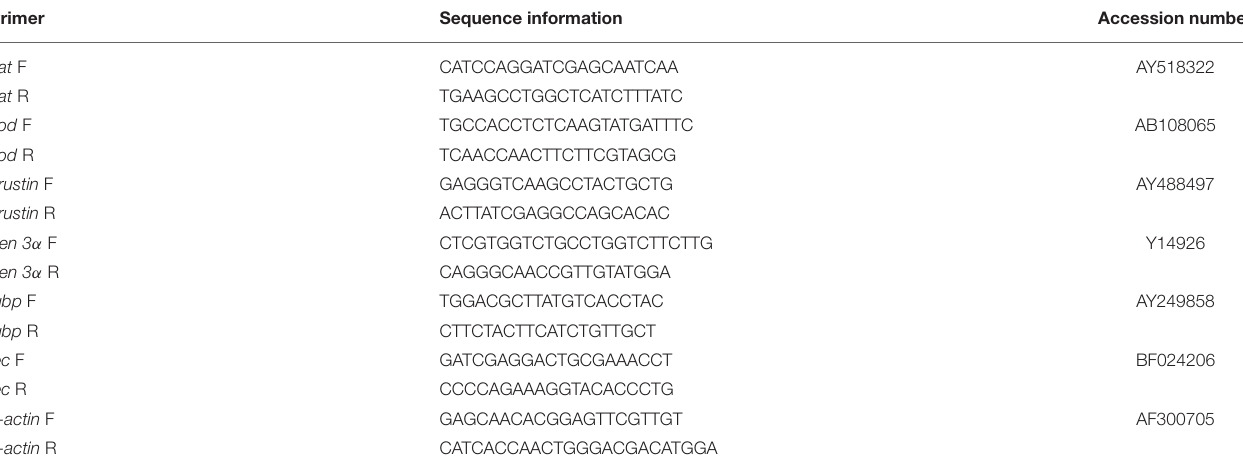
TABLE 1 | Primers used to amplify immune-related genes in the present study.